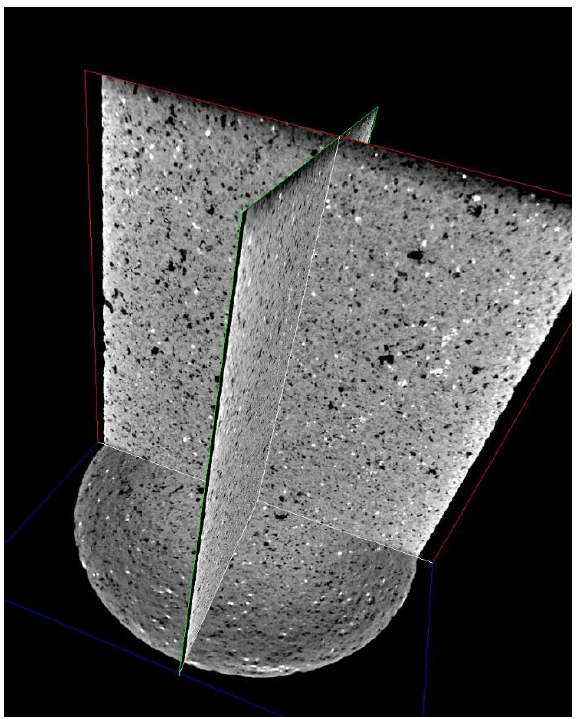
Figure 2. CT images of cylindrical siltstone sample with diameter of 13.0 mm and height of 13.5 mm (black cavities represent pores).